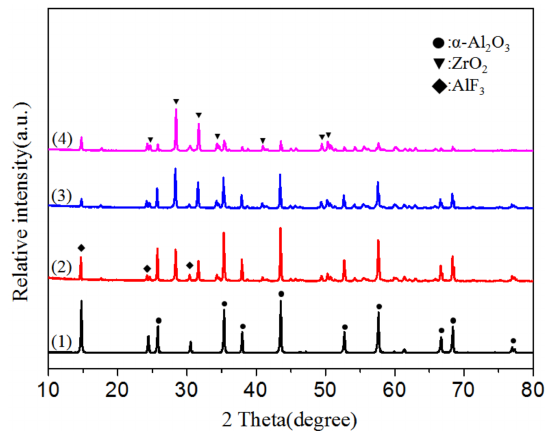
Figure 9. X-ray diffraction (XRD) patterns of the used catalysts, ( 1 ) γ -Al 2 O 3 , ( 2 ) 9% Zr/ γ -Al 2 O 3 , ( 3 ) 16% Zr/ γ -Al 2 O 3 and ( 4 ) 35% Zr/ γ -Al 2 O 3